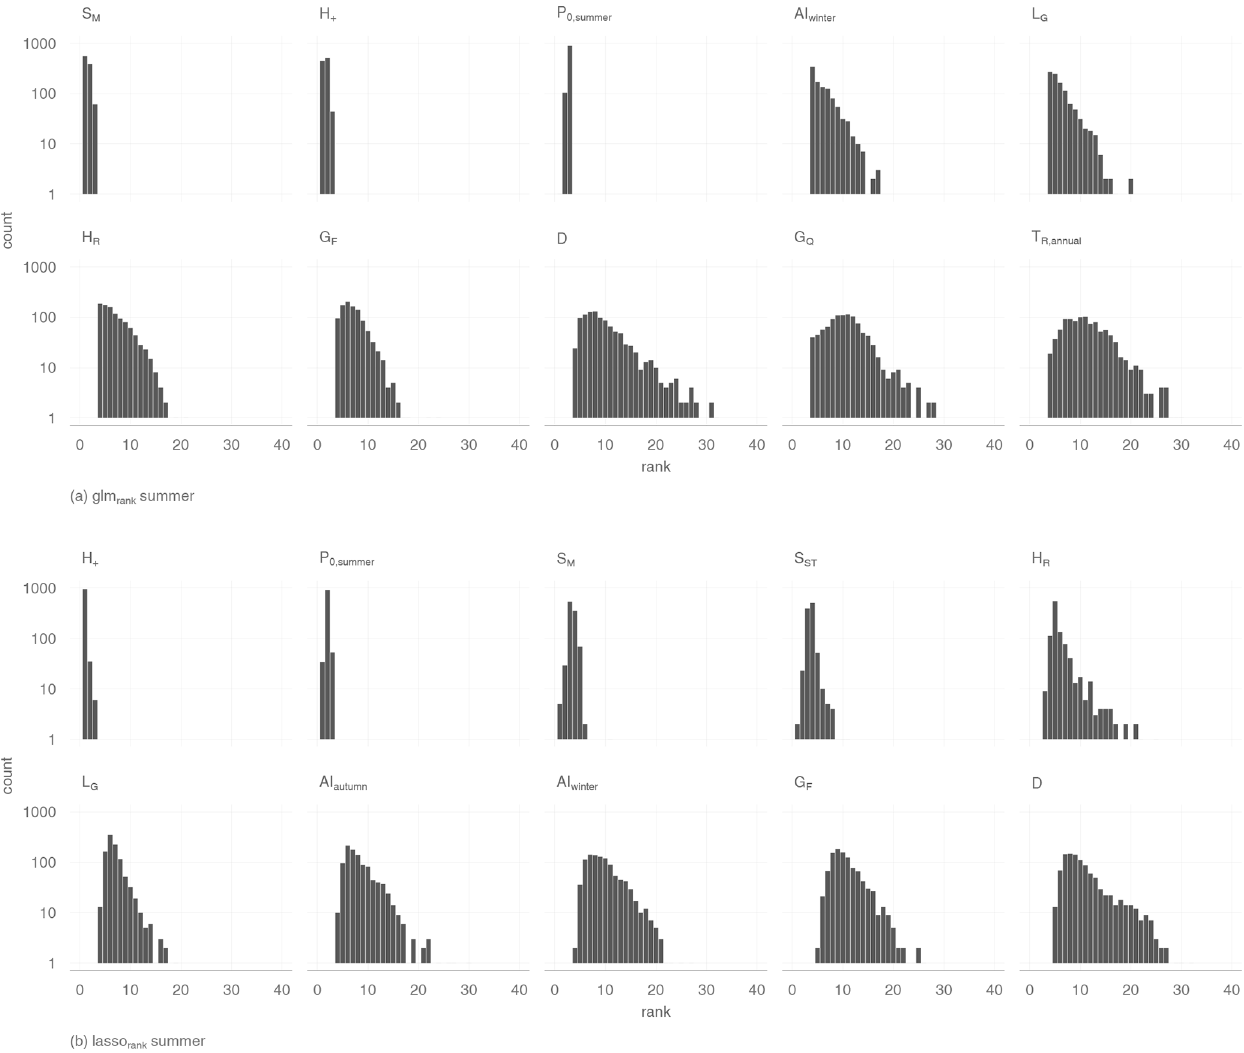
Figure 8. Count of all variable rankings of all 1000 iterations on a log scale for summer low flow. The 10 best variables are listed after their averaged